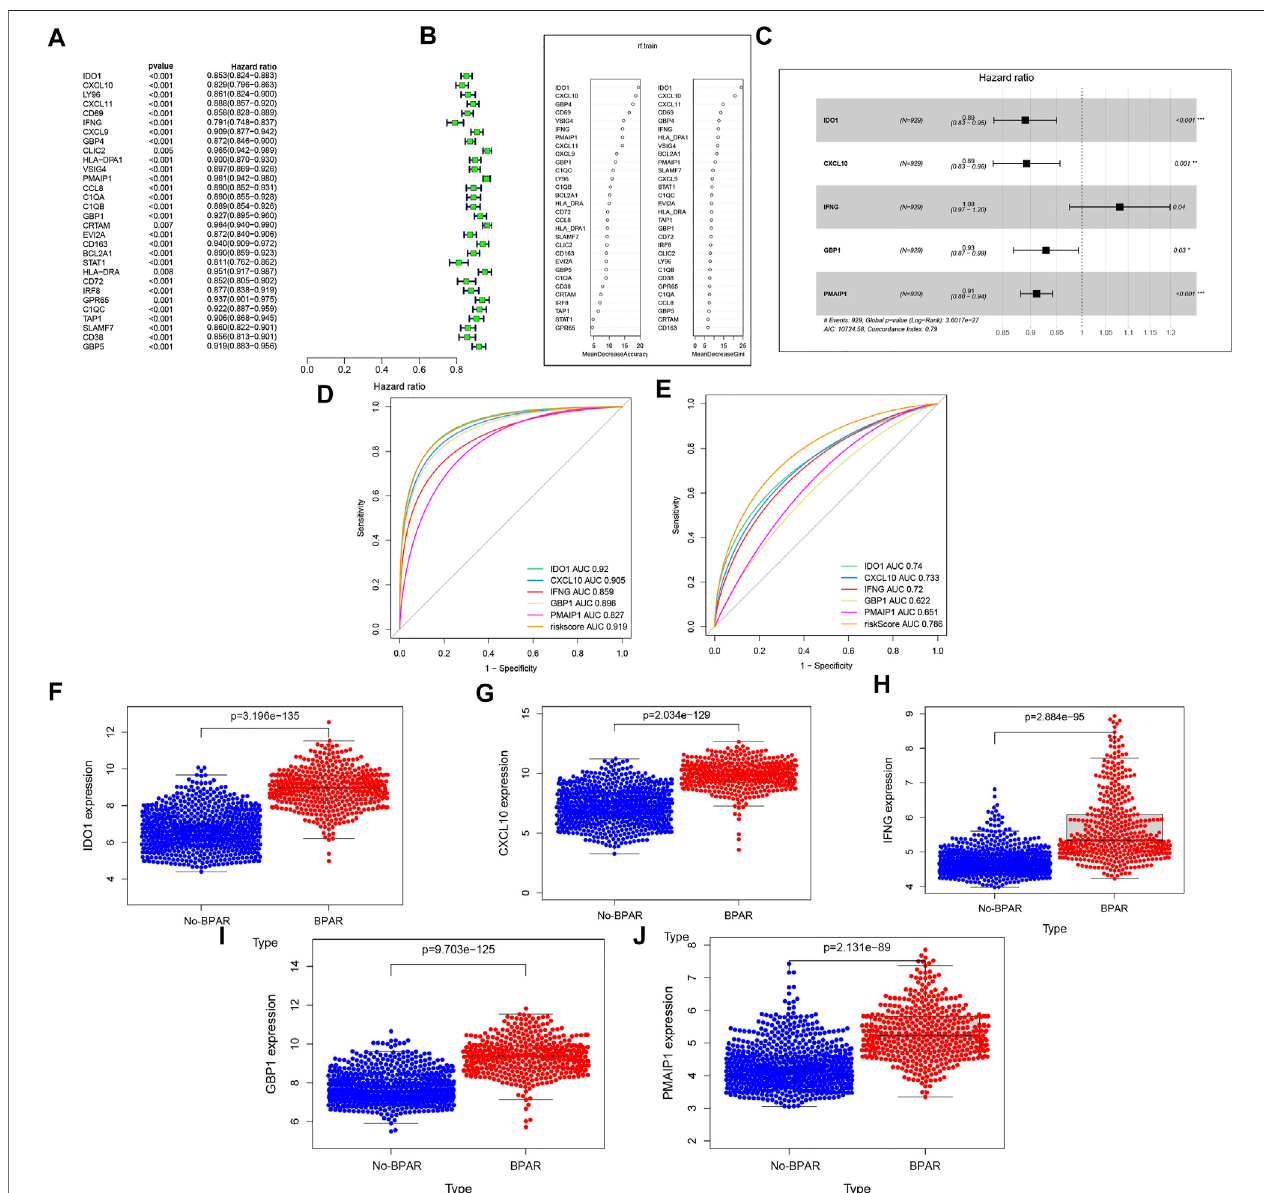
FIGURE 2 | (A) : the single-factor prediction model of the training set. (B) : According to the expression matrix of these 30 genes in the training set, the result of random forest dimensionality reduction. (C) : the multi-factor prediction model of the expression matrix of these 10 genes in the training set. (D) : ROC curve of the prediction result of the training set. (E) : ROC curve ofthe prediction result of the validation set (F – J) : the expression levels of these fi ve target genes in the samples. Blue represents the expression in the No-BPAR group and orange represents the expression in the BPAR group with a p -value less than 0.05.